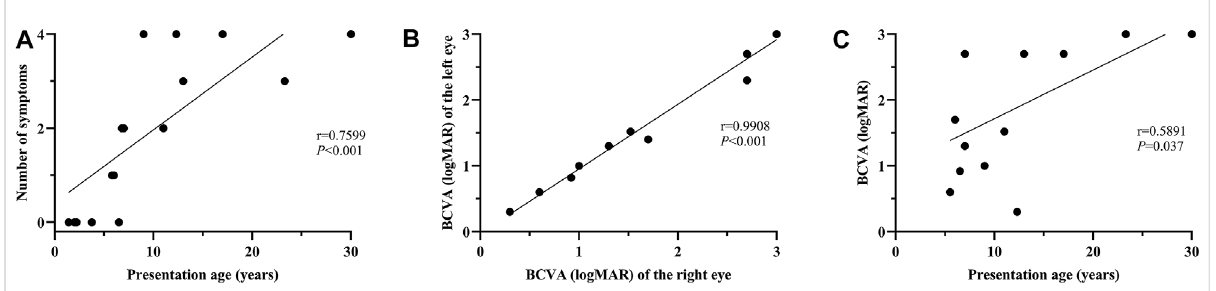
FIGURE 2 Correlation analysis between the number of systemic symptoms and age at presentation; between BCVA and age at presentation. (A) A signi fi cant positive correlation is evident between the number of systemic symptoms and presentation age (r = 0.7599, p < 0.001). (B) Binocular symmetry of BCVA in these patients. A strong correlation is detected between the BCVA of the right and left eyes (r = 0.9908; p < 0.001). (C) A moderate correlation is found between BCVA and age at presentation (r = 0.5891, p =